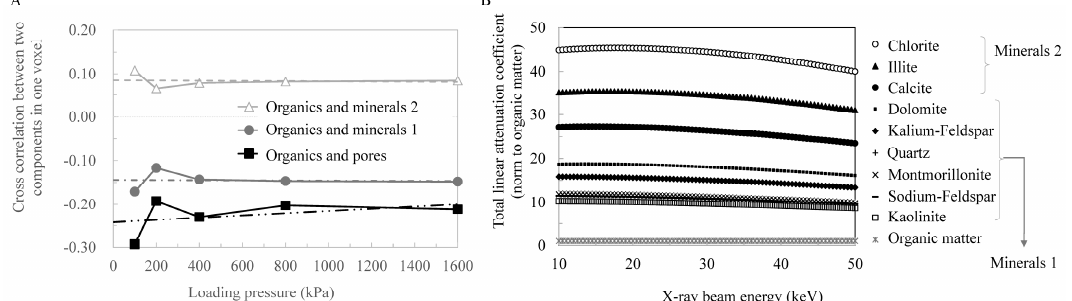
Figure 4. Variation of the correlation coefficient of different components. ( A ) Correlation coefficient of matter varies with loading pressure changes; ( B ) Three components of the soil: Minerals 1, Minerals 2, and organic matter.